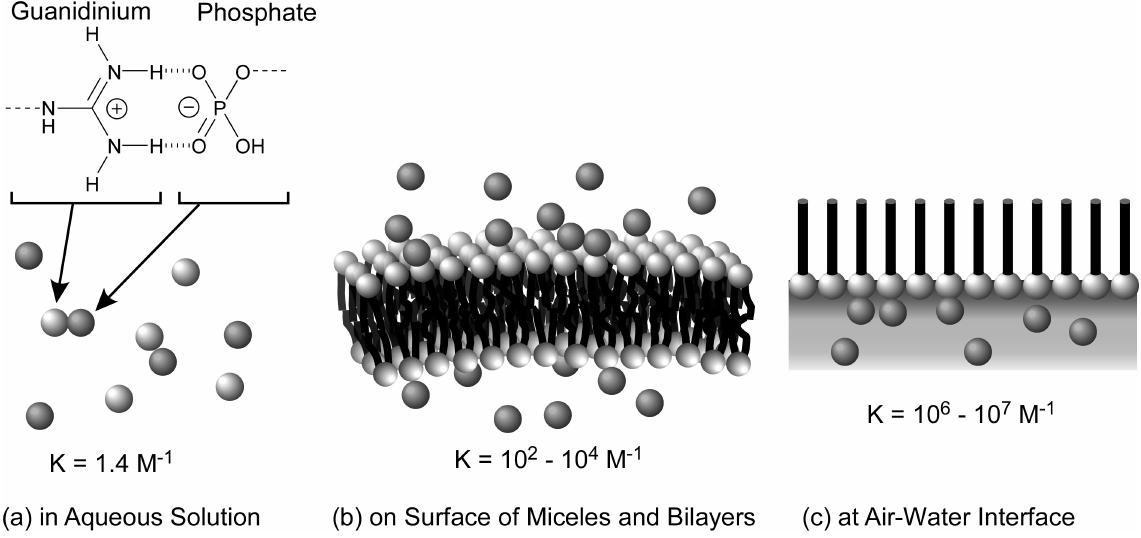
Figure 1. Typical binding constants between phosphate and guanidinium for various aqueous media interfaces: (a) in aqueous solution; (b) on the surface of micelles and bilayers; (c) at the air-water interface. Reprinted with permission from [4] ©1996, American Chemical